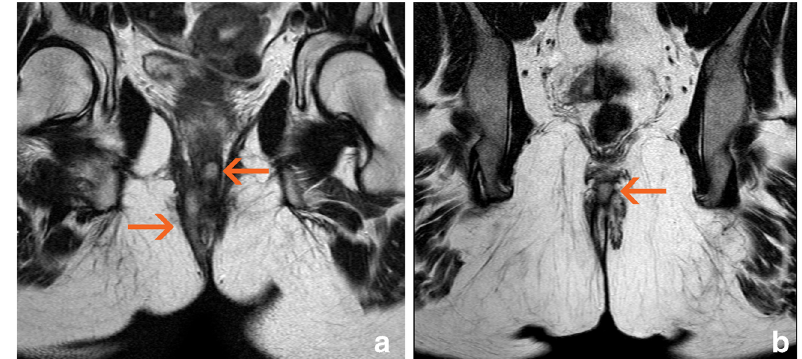
Axial T2-weighted sequences after 24 weeks of treatment reveal that the distal part of the fistula shows signs of healing (hypointensity); how- ever, the intersphincteric fluid collection persists